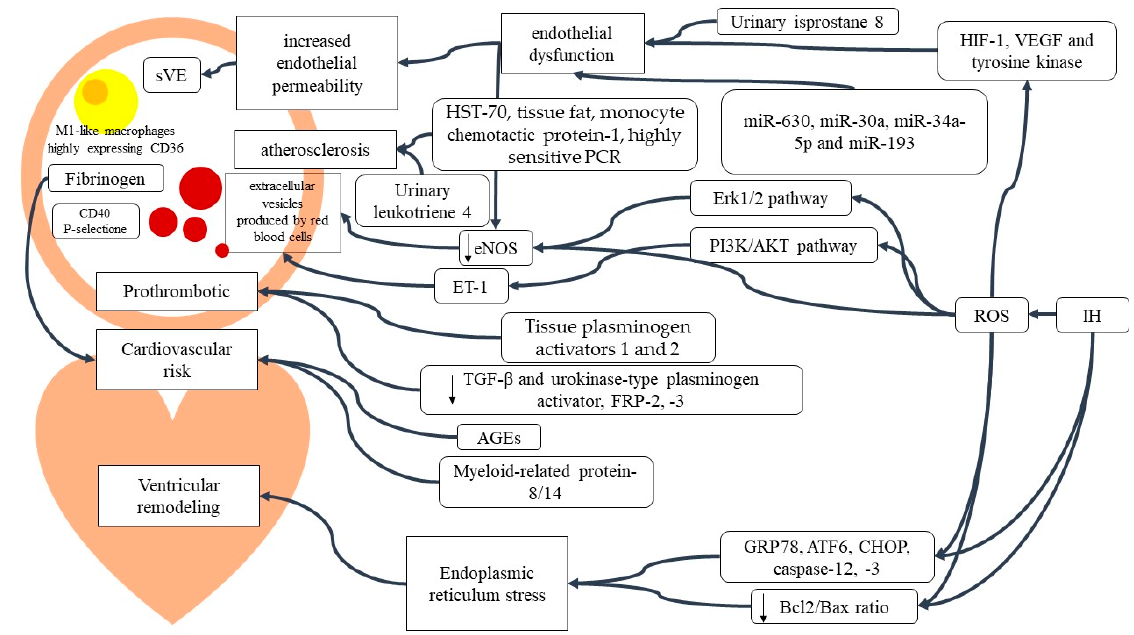
Figure 1. Mechanisms of cardiovascular risk in OSAS.